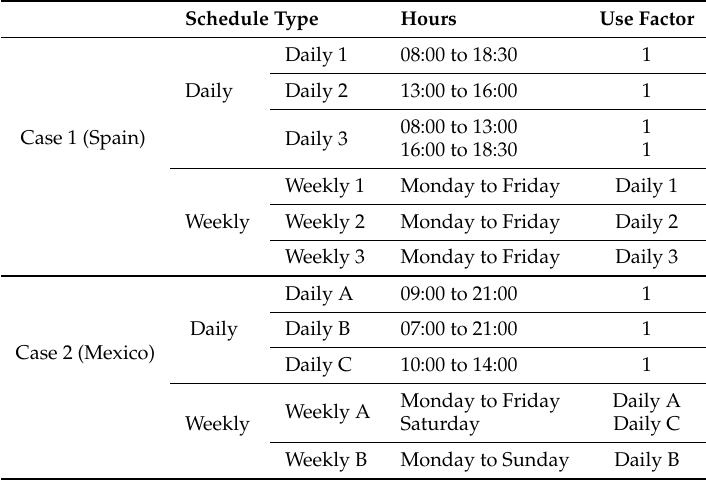
Table A3. Types of schedules in the